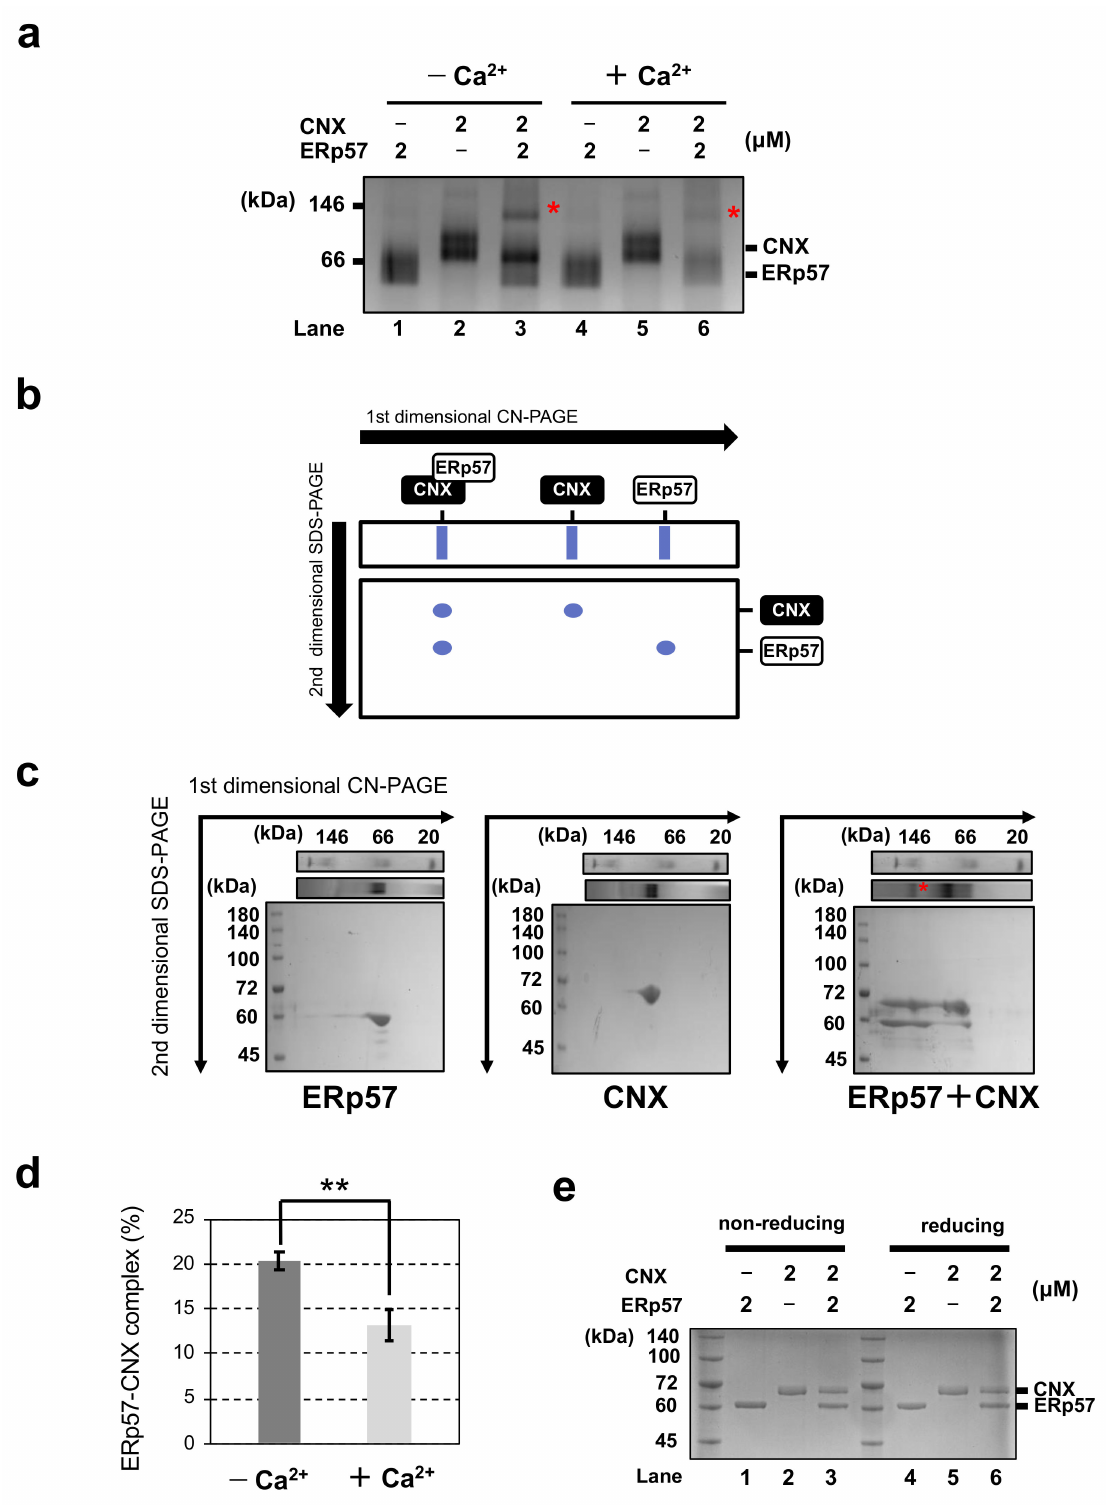
Figure 1. Complex formation between ERp57 and CNX is impaired by Ca 2+ . ( a ) Clear-native PAGE of ERp57 and CNX in the presence or absence of Ca 2+ . ( b ) Schematic representation of two-dimensional PAGE. ( c ) Gel images of two-dimensional PAGE in Figure 1a, lanes 1, 2, and 3. ( d ) Quantification and statistical analysis of the fraction of the ERp57-CNX complex shown in Figure 1a, lanes 3 and 6 ( n = 3, mean ± SD). ** p < 0.01. ( e ) Non-reducing and reducing SDS-PAGE of ERp57 and CNX without Ca 2+ . Experiments were independently repeated three times with reproducible